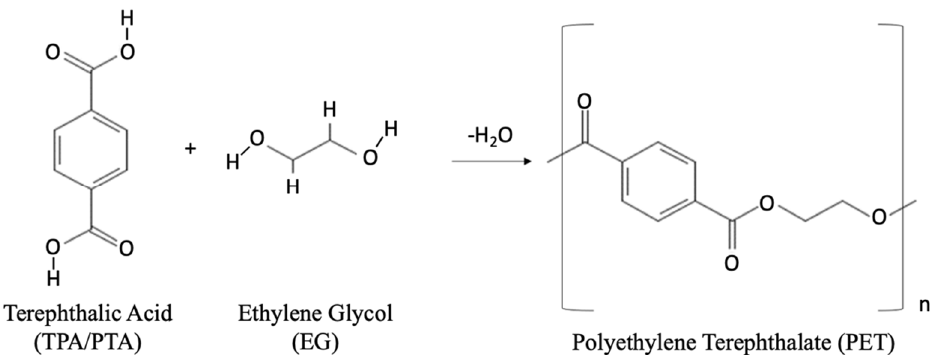
Figure 1. Chemical reaction of terephthalic acid and ethylene glycol for the formation of polyeth- ylene terephthalate.